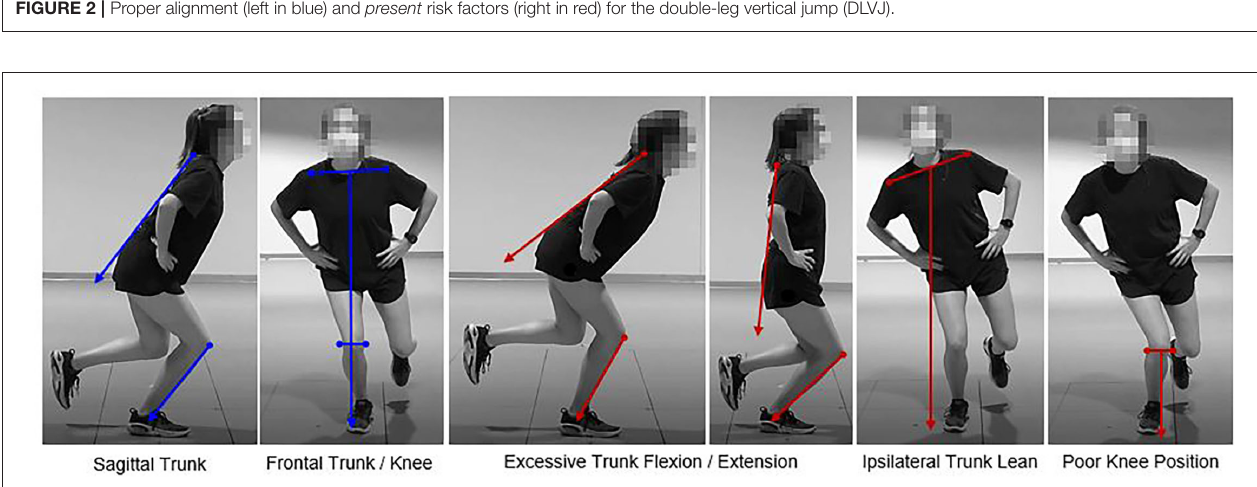
FIGURE 3 | Proper alignment (left in blue) and present risk factors (right in red) for the single-leg tasks.